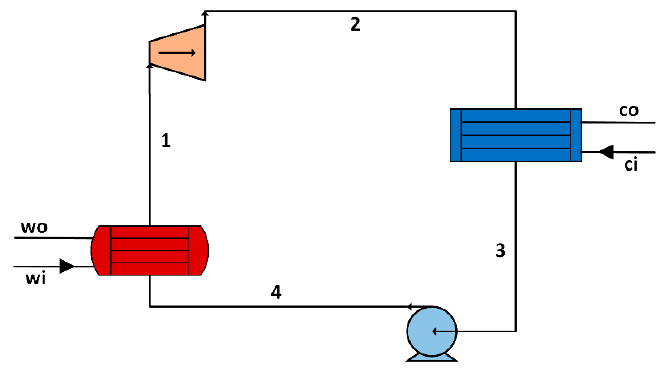
Figure 1. Flow diagram of an ORC for an OTEC plant.